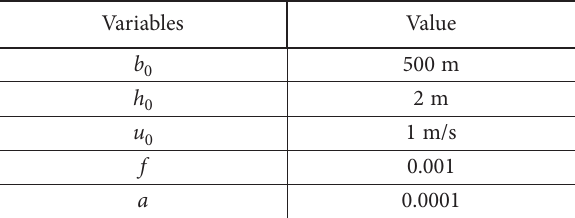
h is the 0 u is the initial velocity 0